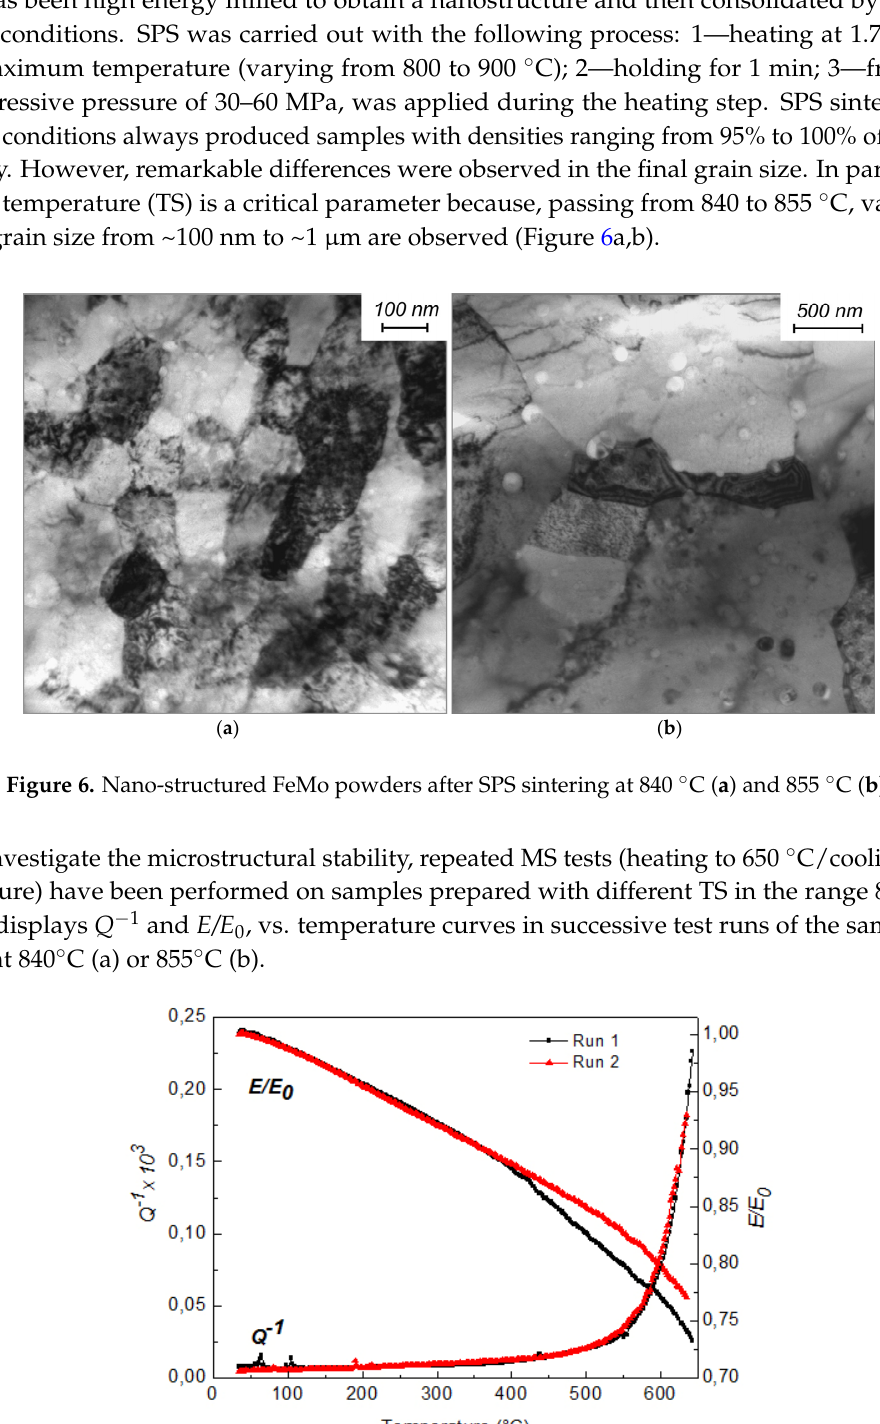
Figure 7. Fe ‐ Mo alloy produced via SPS from nano ‐ structured powders. Trends of Q − 1 and E/E 0 vs. temperature in successive test runs carried out on samples sintered at 840 °C ( a ) and 855 °C ( b ). Q − 1 of the sample sintered at 840 °C exponentially increases with temperature while modulus monotonically decreases except in the first run where an anomalous drop has been observed above 380 °C. All the curves of the sample sintered at 855 °C clearly exhibit the same behavior. The as ‐ prepared samples have nanometric grain size and homogeneously distributed nano ‐ porosity. These features make them hard and brittle, thus small cracks may form during the first test to accommodate internal stresses. The samples do not show macroscopic ruptures also after several test cycles and cracks are not visible by an external inspection also at high magnification. The explanation of the modulus instability is based on TEM observations showing pores often separated by metallic ligaments of the order of tens of nanometers. A failure of these ligaments is supposed, thus the cracks have a nanometric size. Crack formation reduces the effective sample thickness h and, according to Equation (1), leading to a sudden decrease of the resonance frequency f from which is calculated the modulus E . In fact,